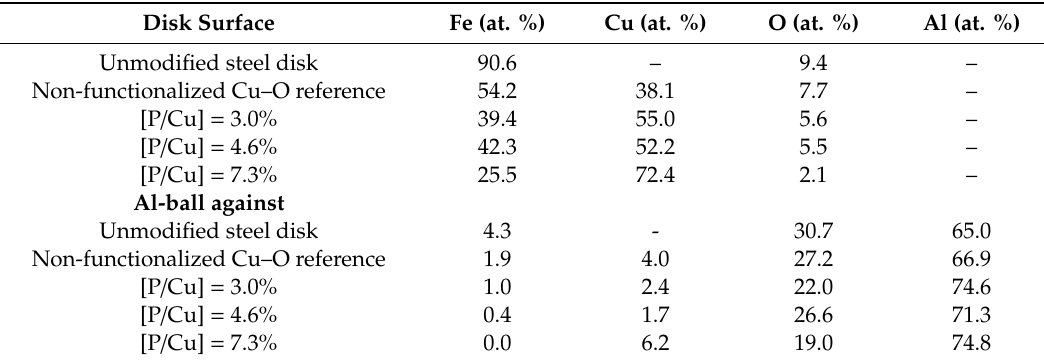
Table 3. Chemical composition of the tested pairs as shown in Figure 4 determined by